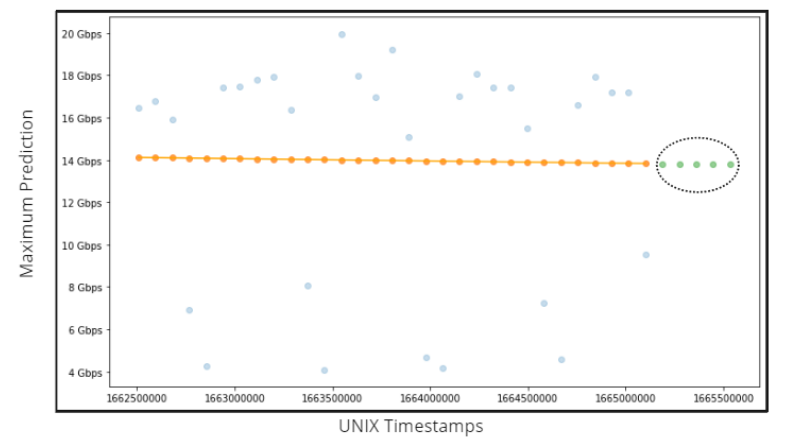
Figure 21. The maximum data usage prediction.